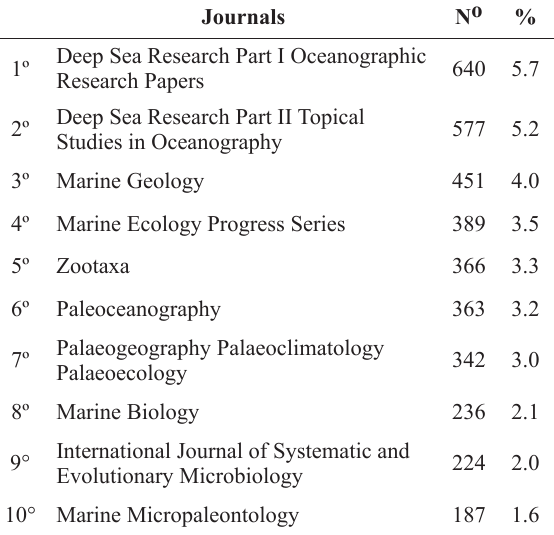
Number of articles published and percentage of the 10 journals that published the most articles on the topic “deep sea” between 1987 and